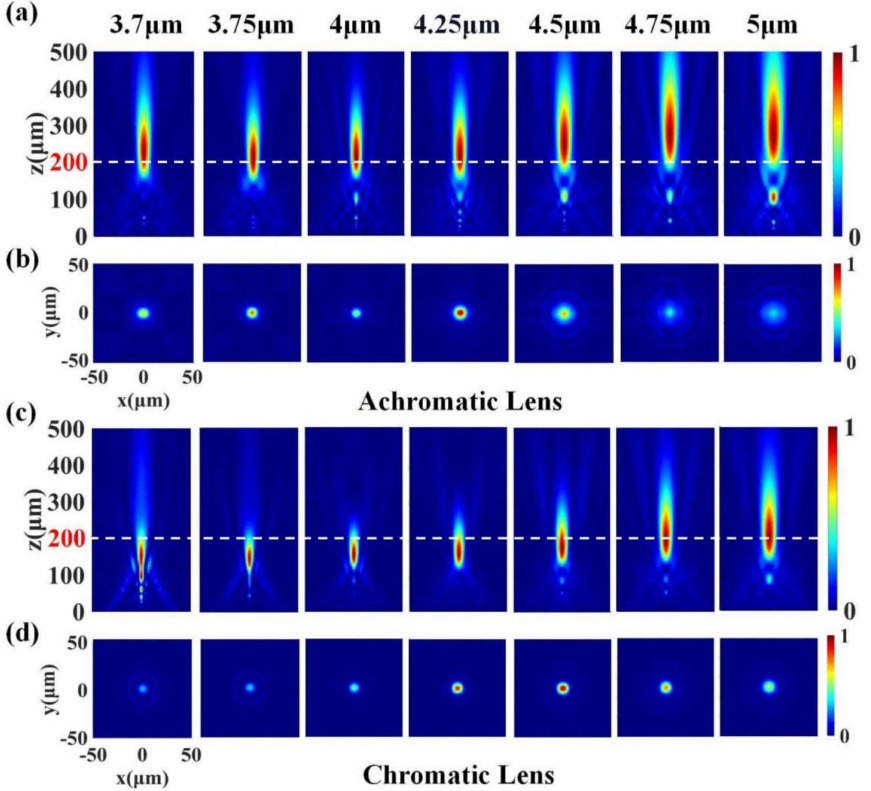
Figure 5. Simulation results within the working bandwidth of 3.7–5 µ m. The angle θ between the incident light and the optical axis is 0 ◦ . ( a ) Normalized x – z plane light intensity distributions for seven different wavelengths of the achromatic lens. ( b ) Normalized x – y plane light intensity distributions on the designed focal plane (at 200 µ m), marked with a white dashed line in ( a ). ( c ) Normalized x – z plane light intensity distributions for seven different wavelengths of the chromatic lens. ( d ) Normalized x – y plane light intensity distributions on the designed focal plane (at 200 µ m), marked with a white dashed line in ( c ). All focal points fall on the optical